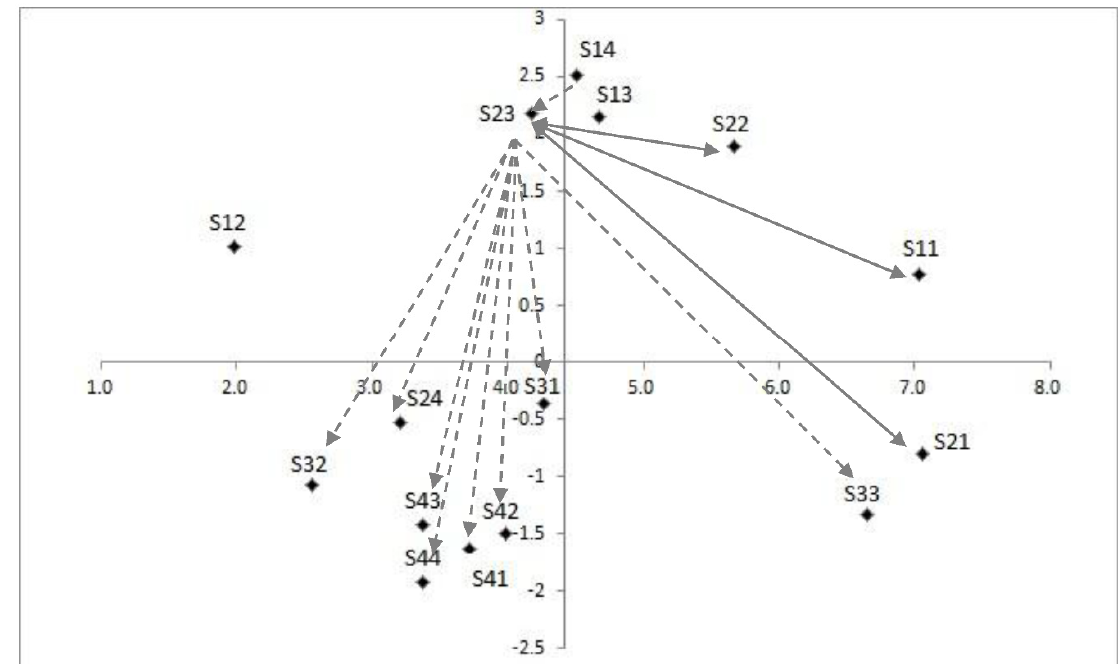
Figure A7. Casual Diagram between S23 and Other Criteria.